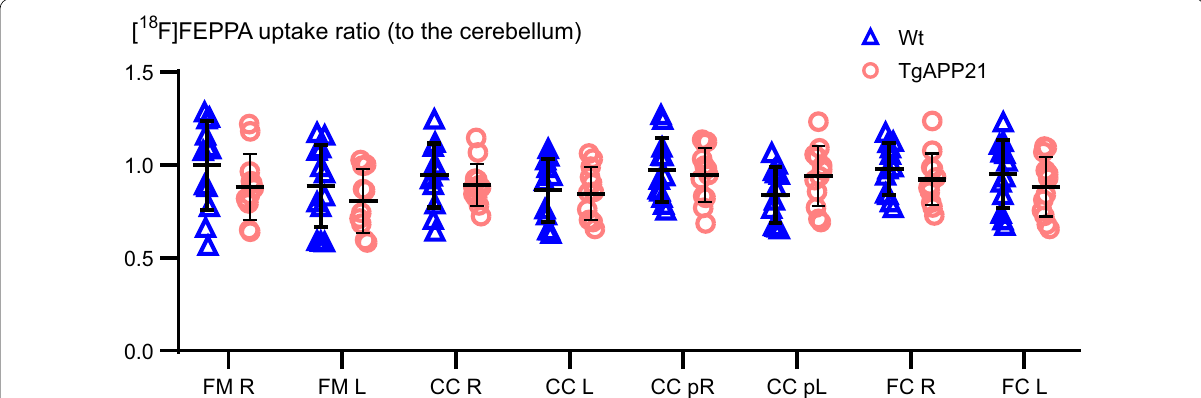
Fig. 2 Transgenic amyloid precursor protein rats did not have an elevated [ 18 F]FEPPA PET WM uptake ratio, to the cerebellum, relative to wild‑type saline rats. Genotype effect was not significant ( P ns, two‑way ANOVA). CC, corpus callosum; FC, frontal cortex; FM, Forceps Minor; p, posterior. = Error